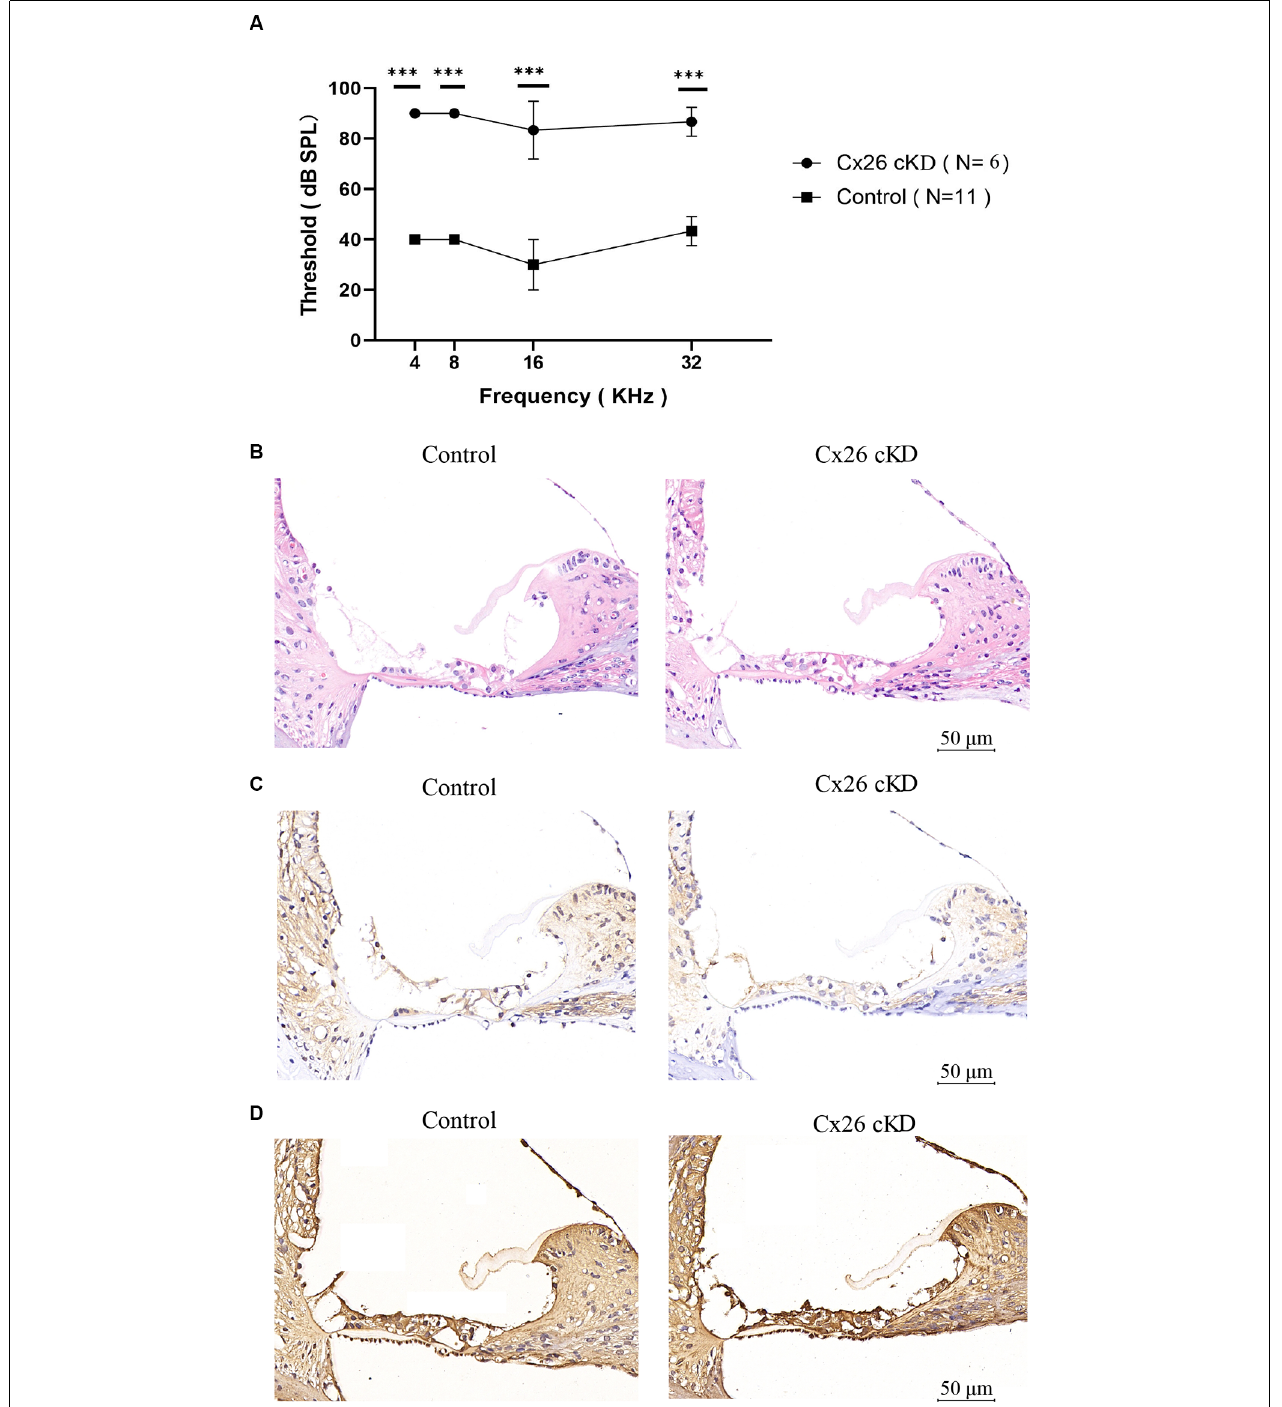
FIGURE 1 | Effect of tamoxifen injection at P0 on the auditory threshold and connexin expression at P21. (A) Auditory thresholds measured by pure tone ABRs vs. tone frequency; ∗∗∗ p < 0.0001. (B–D) Transverse sections of the cochlear duct stained with hematoxylin-eosin (B) or with antibodies selective for Cx26 (C) or Cx30 (D) . Scale bars = 50 µ